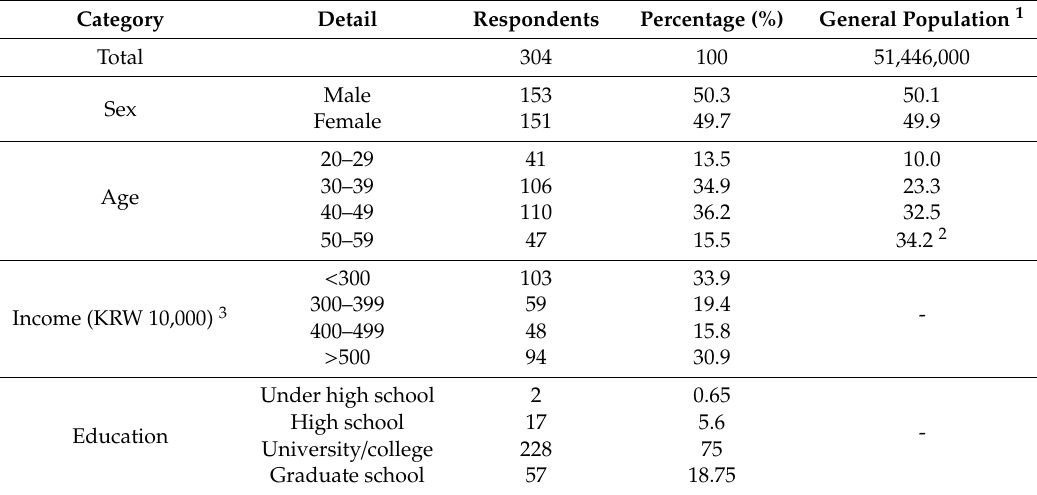
Table 1. Demographic properties of the